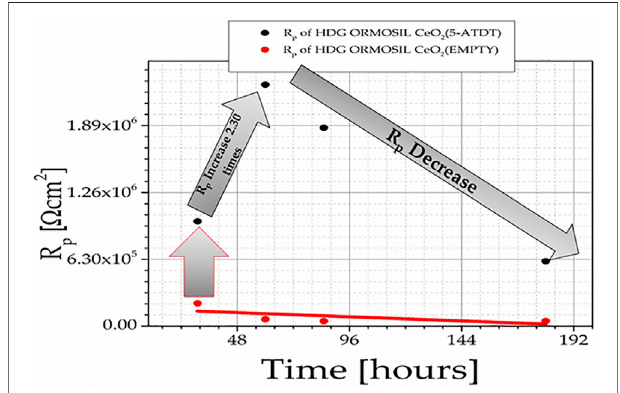
FIGURE 7 | R p of HDG + ORMOSIL + CeO 2 (EMPTY) and HDG + ORMOSIL+CeO 2 (5-ATDT)exposedto0.5 MNaClfor30,60,90,and180